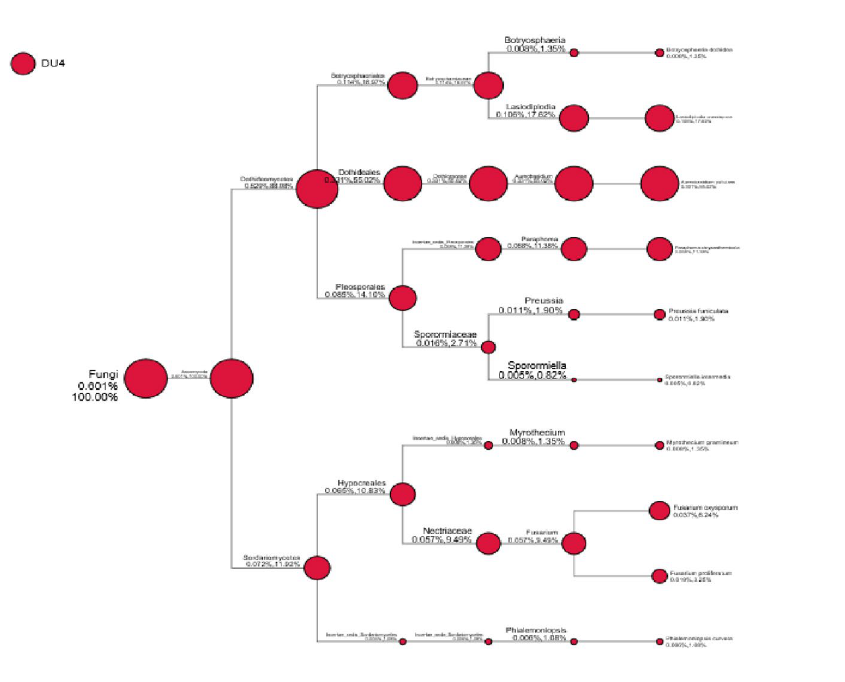
Fig. 2. Taxa diversity information of Lai durian ( Durio kutejensis ) collected from Desa Bukit Sawit, Central Kalimantan, Indonesia, using metagenomic approach based on ITS4 gene. 10 yeast species are present in the